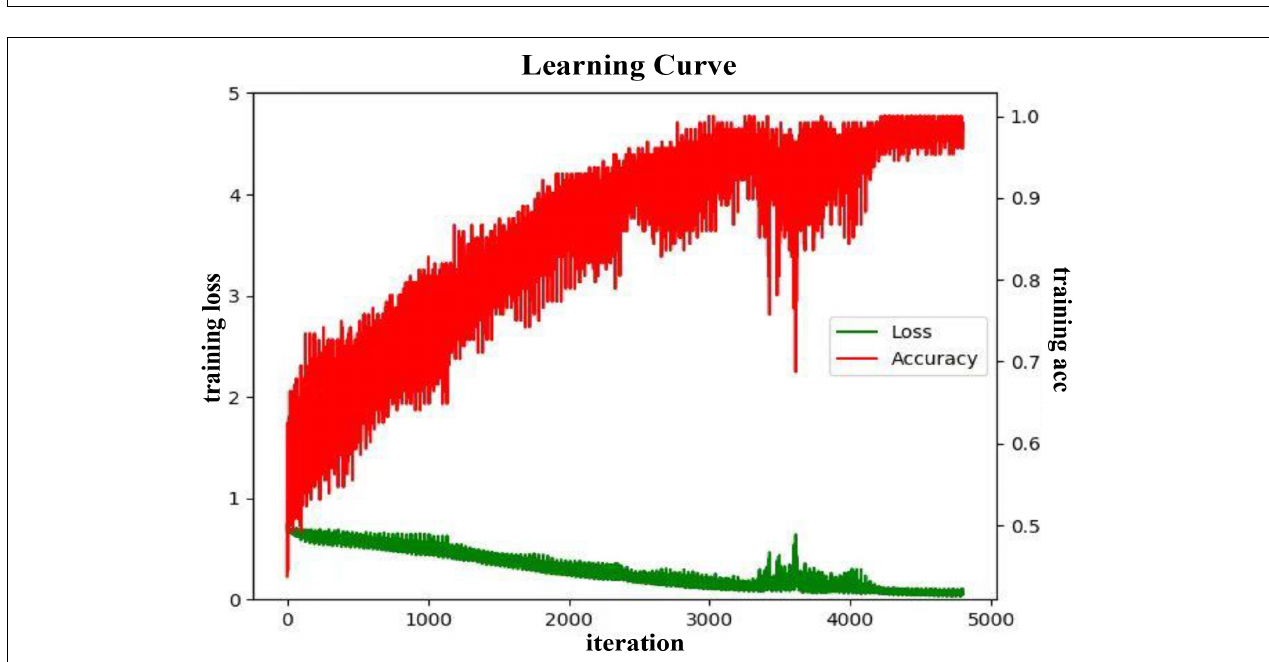
FIGURE 6 | The training process curve in the subject-dependent experiment in the valence.